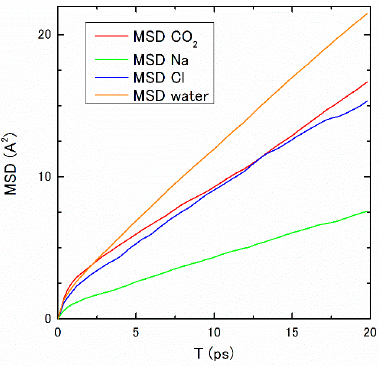
Figure 4. The MSDs of constituent molecules and ions under pressure 30 MP and temperature 275 K.